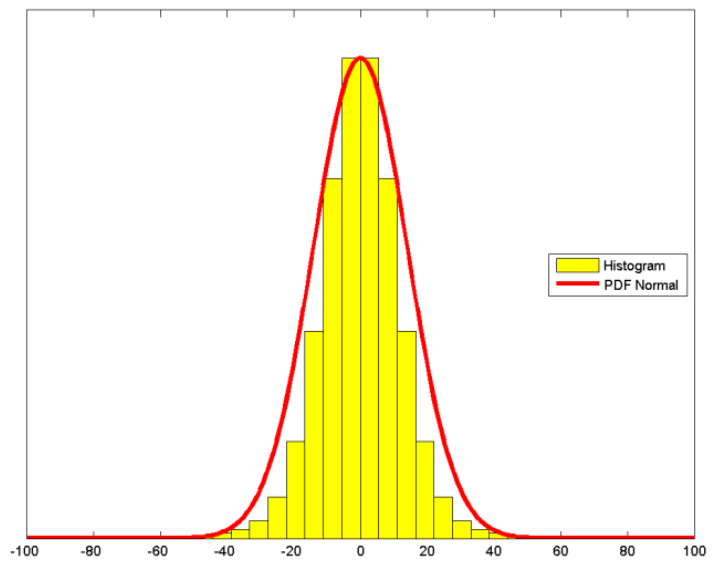
Figure 7. Histogram of the imaginary parts and normal probability density function.